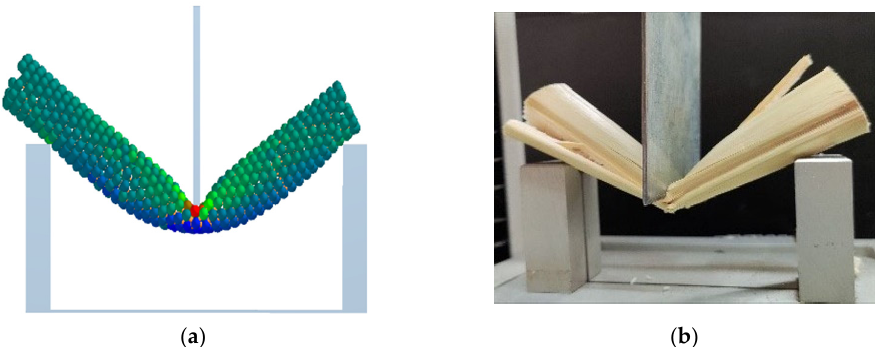
Figure 9. Straw skin bending test. ( a ) Epidermal discrete element bending test; ( b ) epidermal physical bending test.